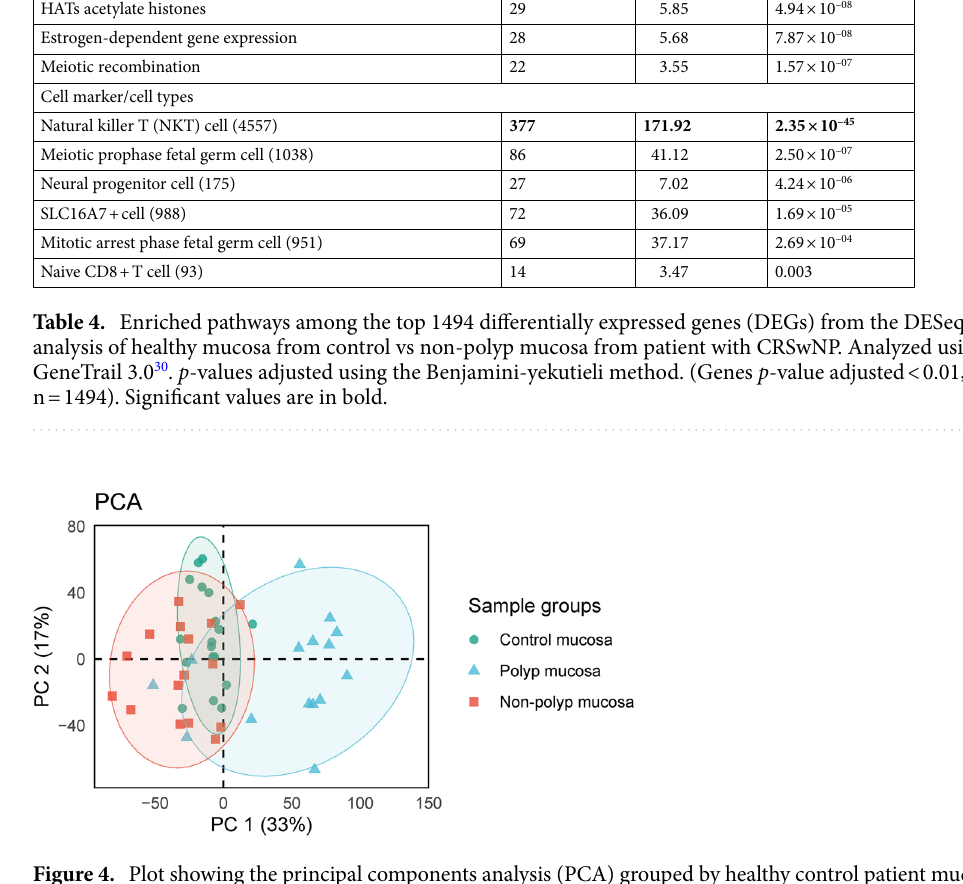
Figure 4. Plot showing the principal components analysis (PCA) grouped by healthy control patient mucosa, non-polyp and polyp mucosa from CRSwNP